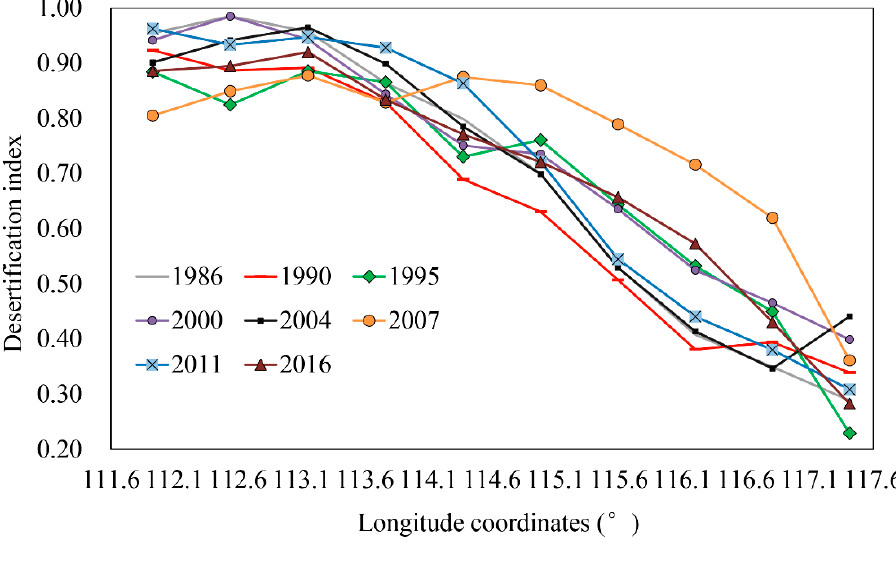
Figure 4. Change of desertification index with longitude in